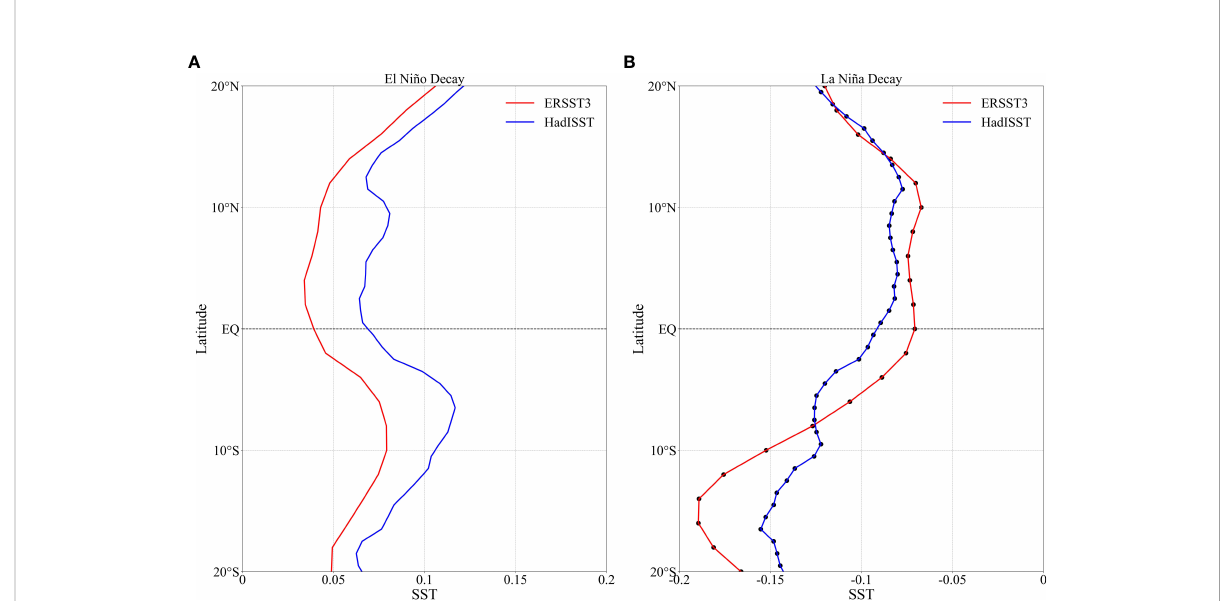
FIGURE 10 (A) Pro fi les of zonal-mean SST over the IPWP region for El Niño decay events and (B) La Niña decay events. The red and blue lines indicate the ERSST3 and HadISST fi elds, respectively. The dark spots represent signi fi cance at the 0.01